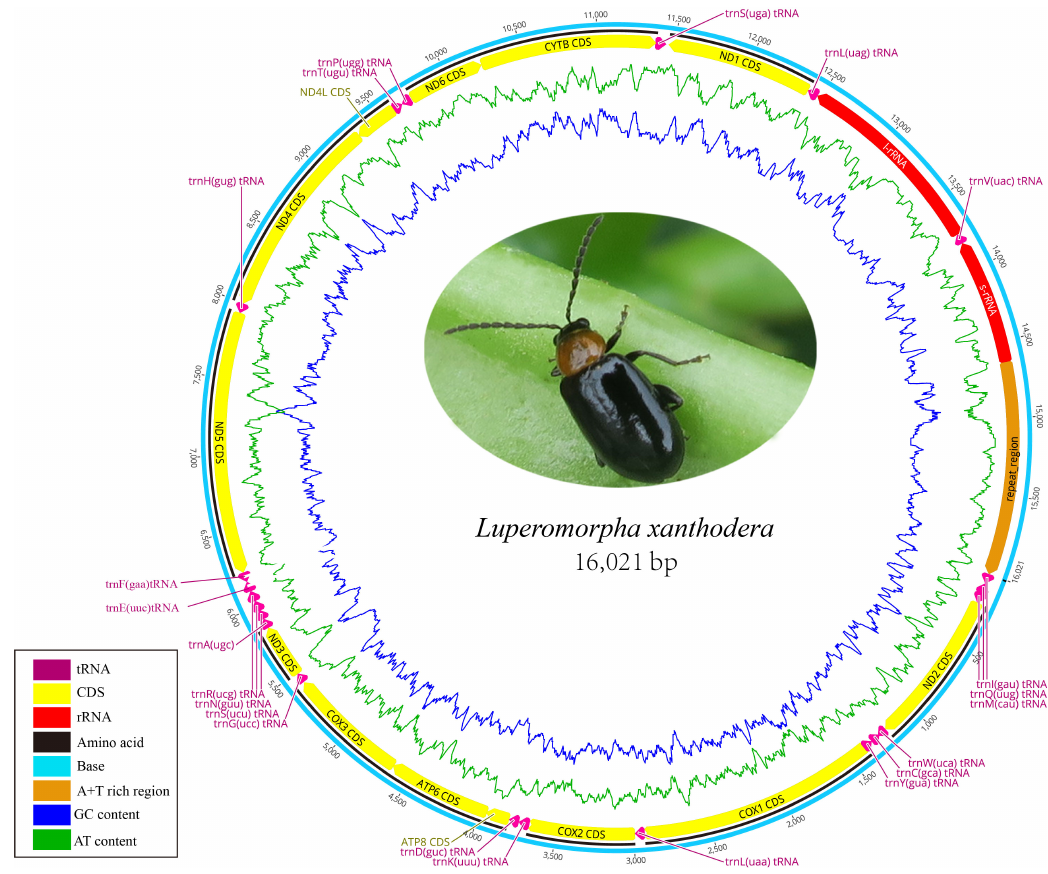
Figure 1. Complete mitogenome map of Luperomorpha xanthodera . The majority strand (F-strand) encodes 14 genes, while the minority strand (R-strand) encodes 23 genes. Protein and rRNA genes are denoted using standard abbreviations. tRNA genes are represented by a single letter for each amino acid, with two leucine tRNAs and two serine tRNAs separated by